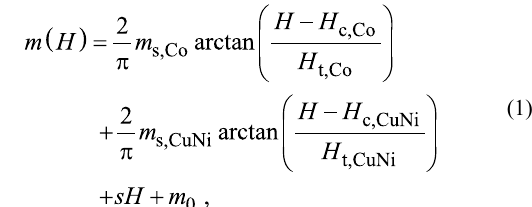
Figure 3: Thickness analysis of the sample series SF 1 NF 2 -AF1. While the solid squares show the data obtained by RBS analysis, the open circles are the values from TEM imaging. The solid lines are a guide to the eye.